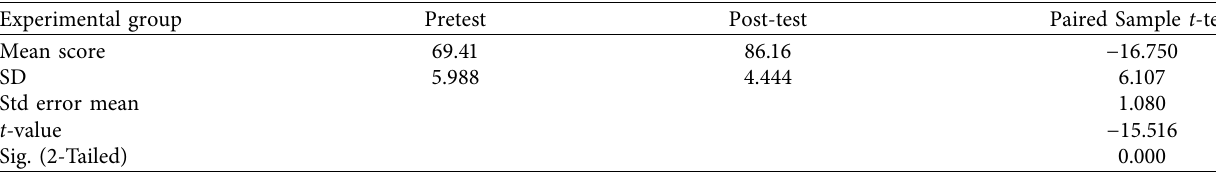
Table 3: Results of Pair Sample t -test in Experimental